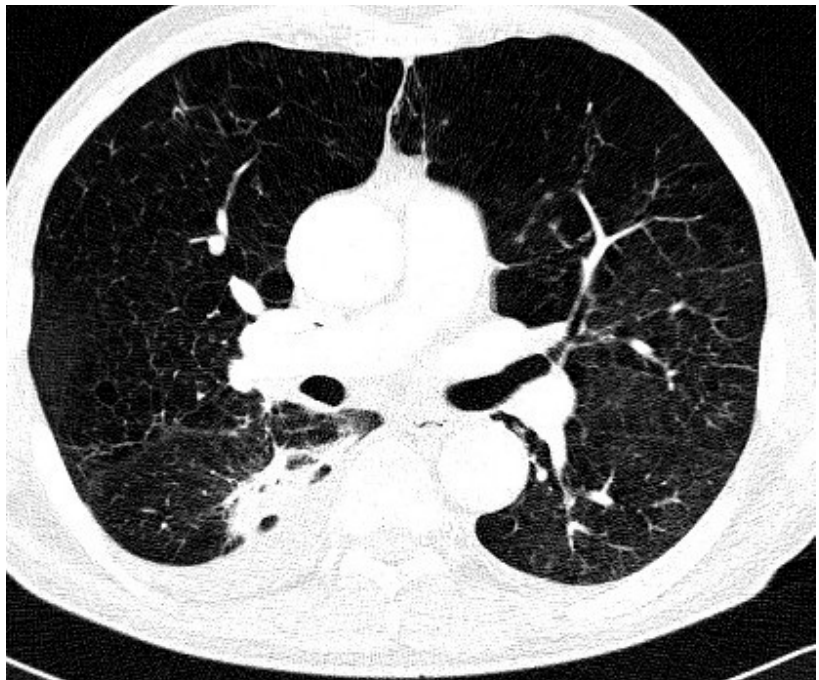
Figure 2. Trans-axial lung window CT scan in patient with NTM-LD and COPD shows diffuse emphysema and cavitating dense infiltrate and pleural thickening in the right apical segment of the lower lobe.